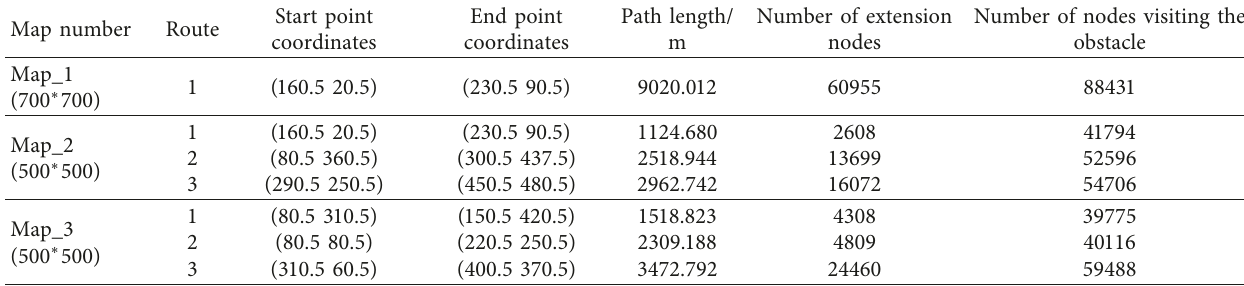
Table 2: A ∗ algorithm for large-scale map path planning.